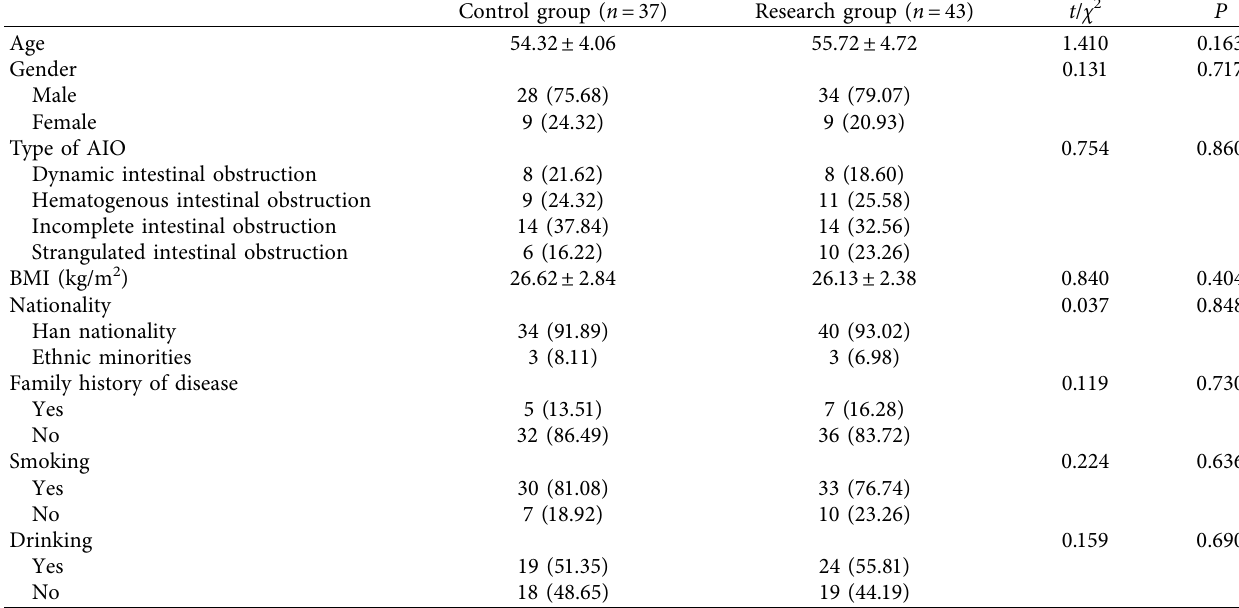
Table 1: Comparison of clinical baseline